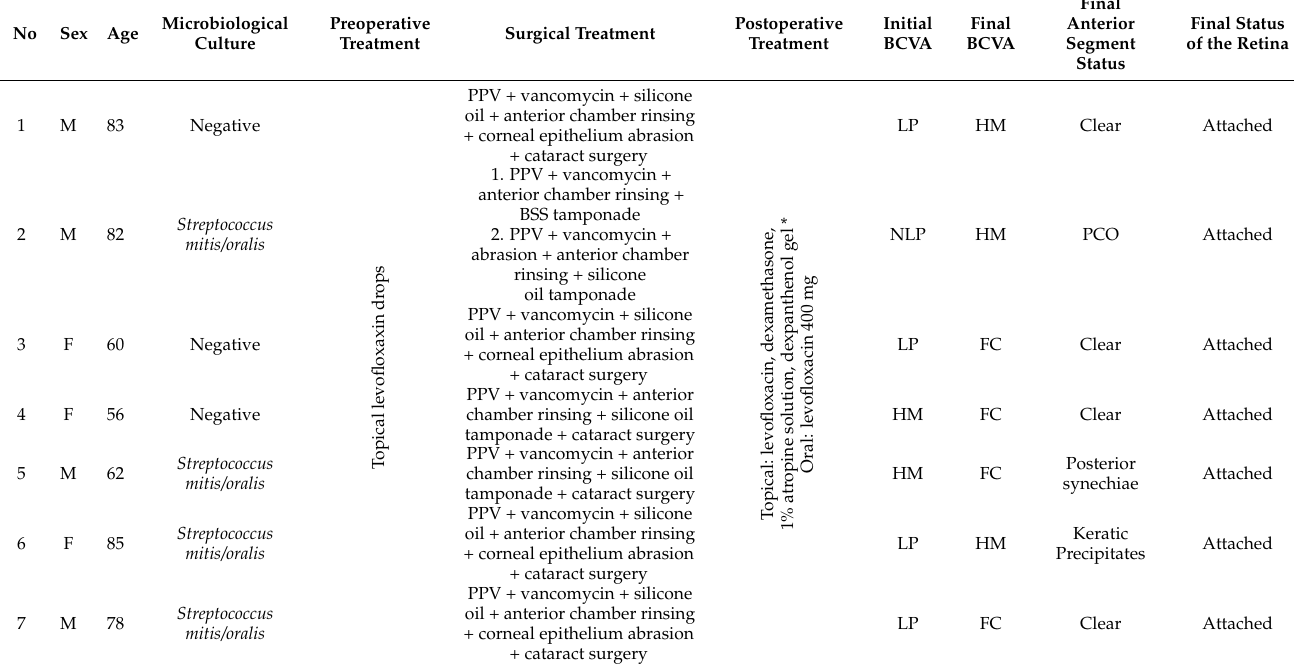
Table 1. Characteristics and treatment outcomes in patients with acute endophthalmitis after aflibercept injection (abbrevia- tions: BCVA, best-corrected visual acuity; BSS, balanced salt solution; F, female; FC, finger counting; HM, hand movement; IOP, intraocular pressure; LP, light perception; M, male; NLP, no light perception; PPV, pars plana vitrectomy; * in patients after corneal epithelium